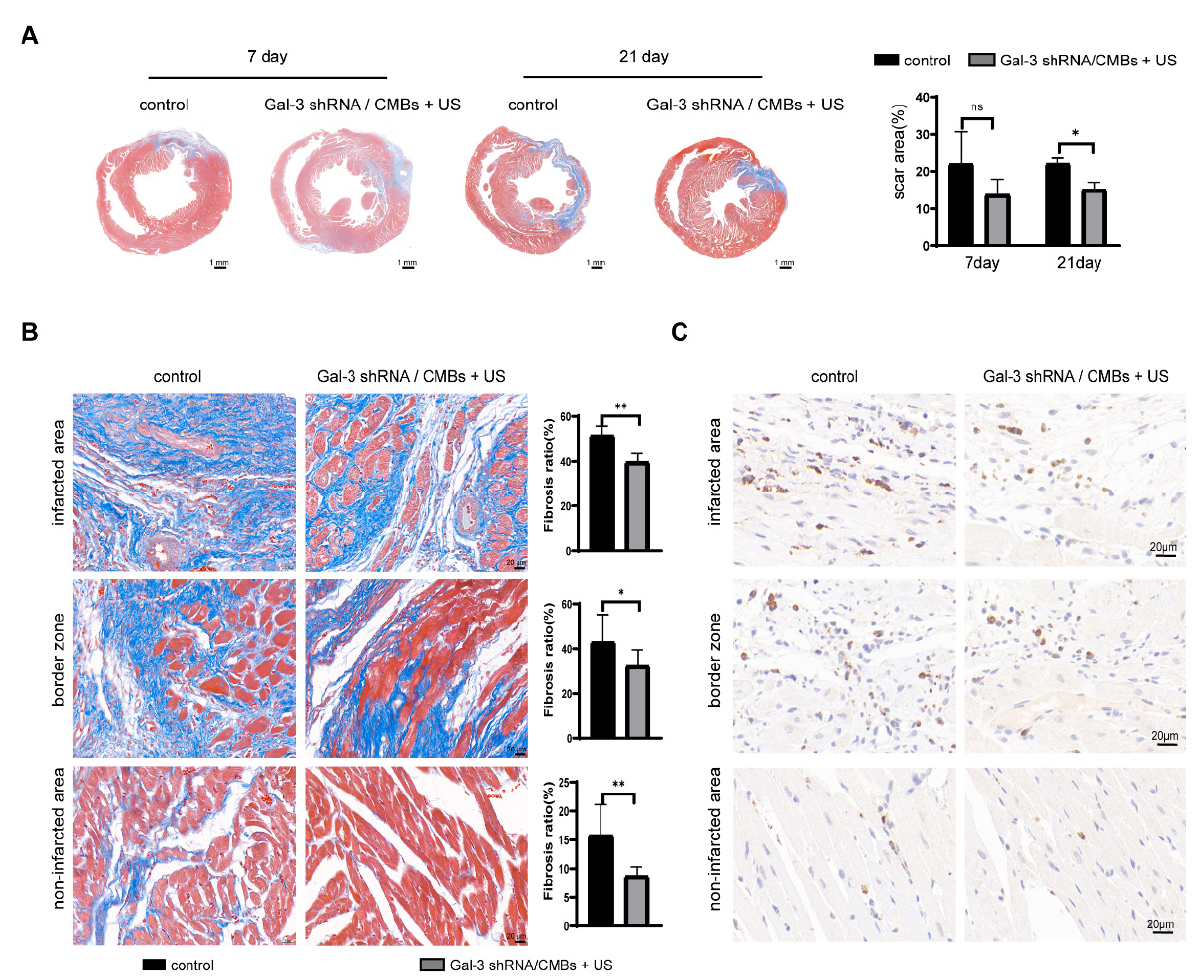
Figure 5. Myocardial fibrosis and macrophage infiltration in MI rats. The blue-stained area represents the fibrous tissue, and the red-stained area represents the myocardial tissue. ( A ) Masson staining and quantitative analysis of scar area in the two groups on day 7 and day 21. ( B ) Degree of fibrosis and quantitative analysis of the fibrosis ratio in three regions between the two groups on day 21 ( C ) Immunohistochemistry staining with CD68+ cells on day 21 ( n = 3, ns p > 0.05, * p < 0.05, ** p < 0.01).